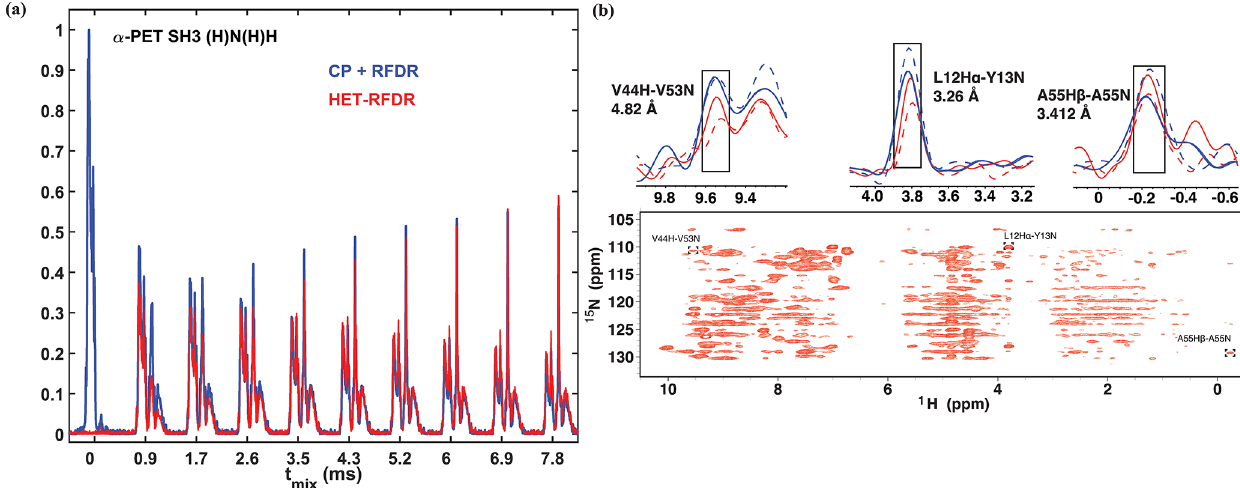
Figure 2. 1D (a) and 2D (b) (H)N(H)H spectra of α -PET-labeled SH3. For all spectra, the first CP from proton to nitrogen was performed with 1.05ms. (a) 1D spectra with different sequences used for the second transfer: CP + RFDR (blue) and HET-RFDR (red). For CP + RFDR, 0.55ms of CP was used. For both RFDR and HET-RFDR, t mix of 0, 0.846, 1.728, 2.592, 3.456, 4.32, 5.184, 6.048, 6.912, 7.7776ms are shown. (b) 2D HET-RFDR at 3.456ms of mixing time. Spectra were recorded with a 600MHz Bruker instrument equipped with a 1.3mm probe and an MAS frequency of 55kHz. The widths of π pulses on proton and nitrogen channels were 5.8 and 6.6µs, respectively. The 1D slices show the intensities of three selected peaks. CP + RFDR (blue) and HET-RFDR (red) at 1.154ms (dashed lines) and 3.456ms (solid lines) mixing are displayed. The experimental parameters are detailed in Tables 1 and 2 in the Experimental methods section. XY8 phase cycling was